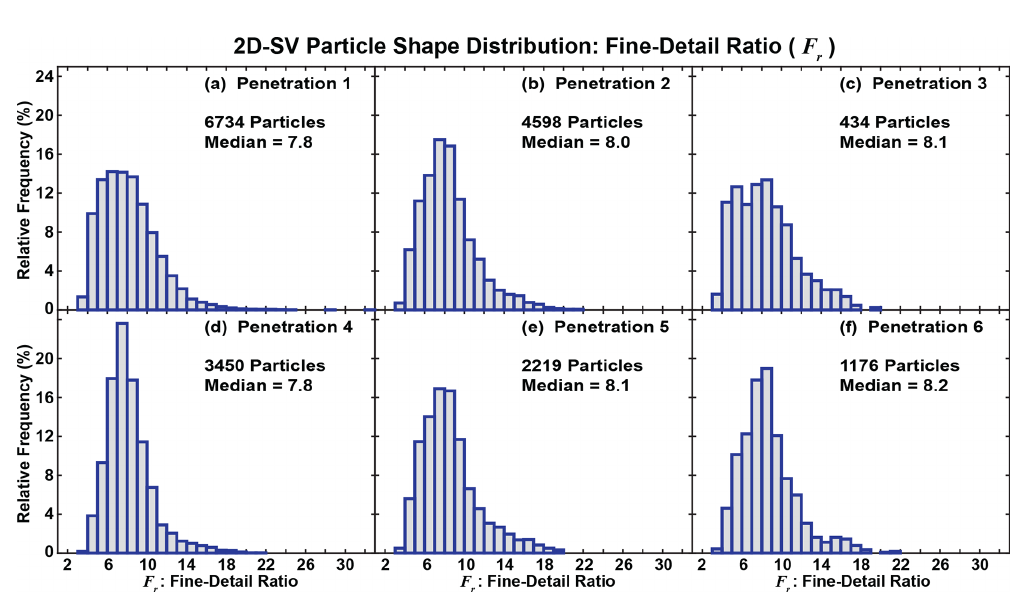
Figure 11. Same as Fig. 8 except for particle fine-detail ratio ( F r